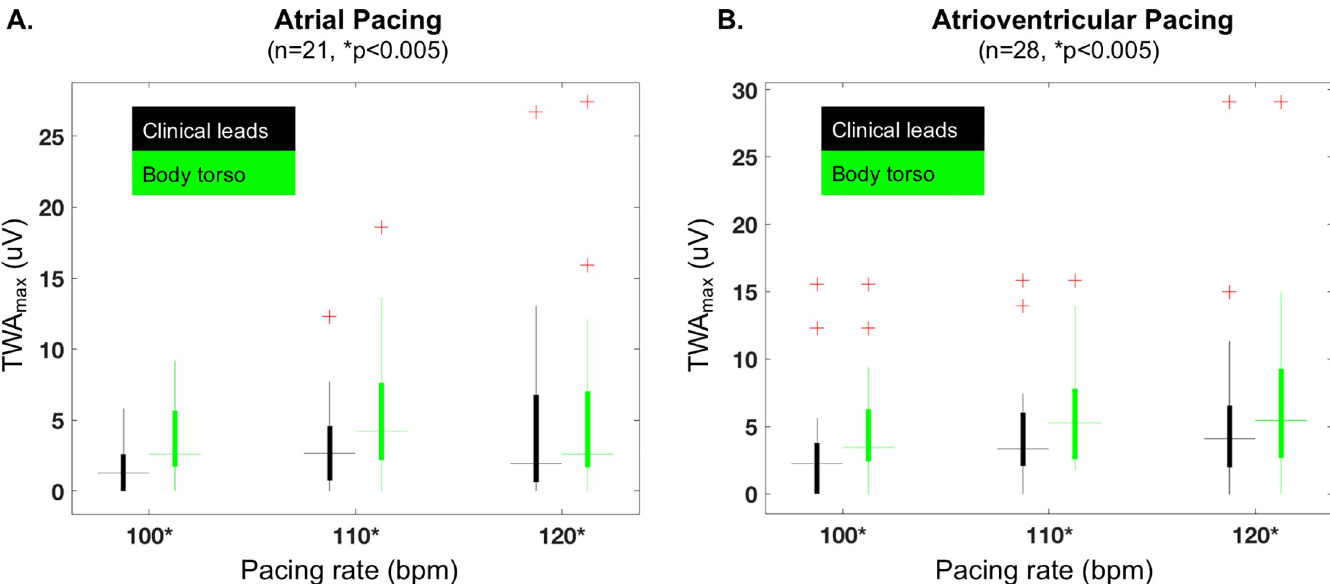
Fig 1. TWA max is compared between clinical leads and body torso for atrial ( A ) and atrioventricular pacing ( B ). TWA max is consistently greater when body torso is sampled vs. clinical leads, regardless of the pacing mode or rate. + indicates outliers.